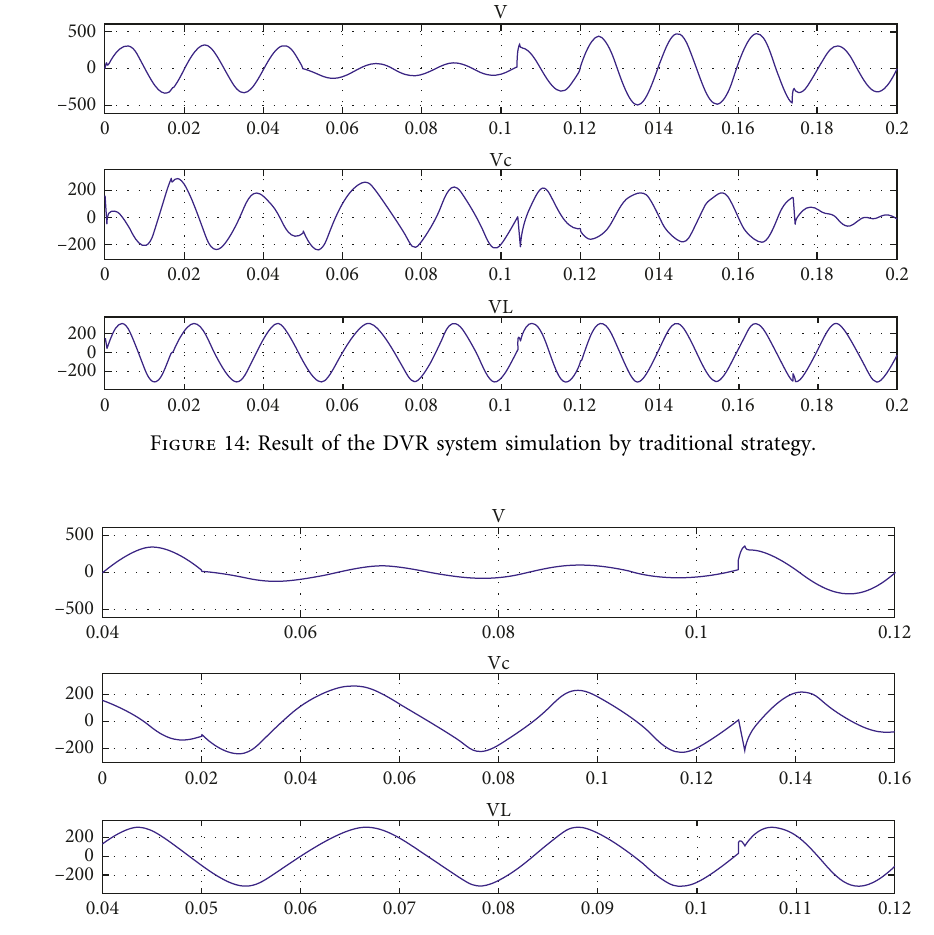
Figure 15: The result of compensating voltage sag.